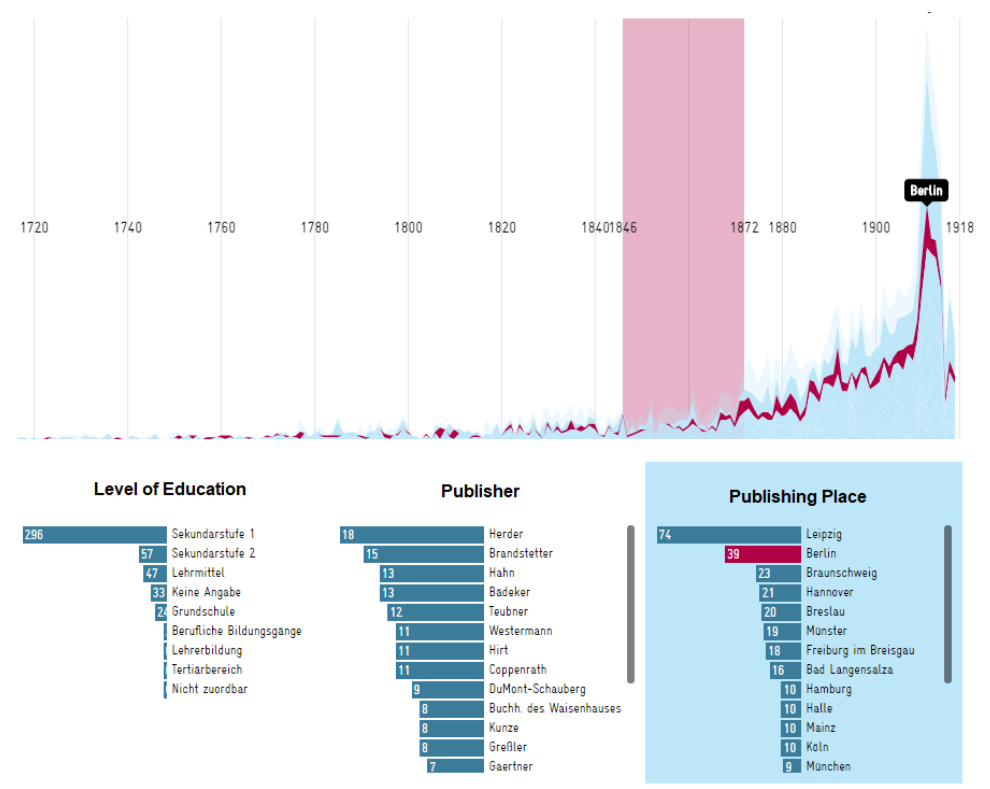
Figure 1. Screenshot of the Georg Eckert Institute for the International Textbook Research (GEI)-Digital-Visualized